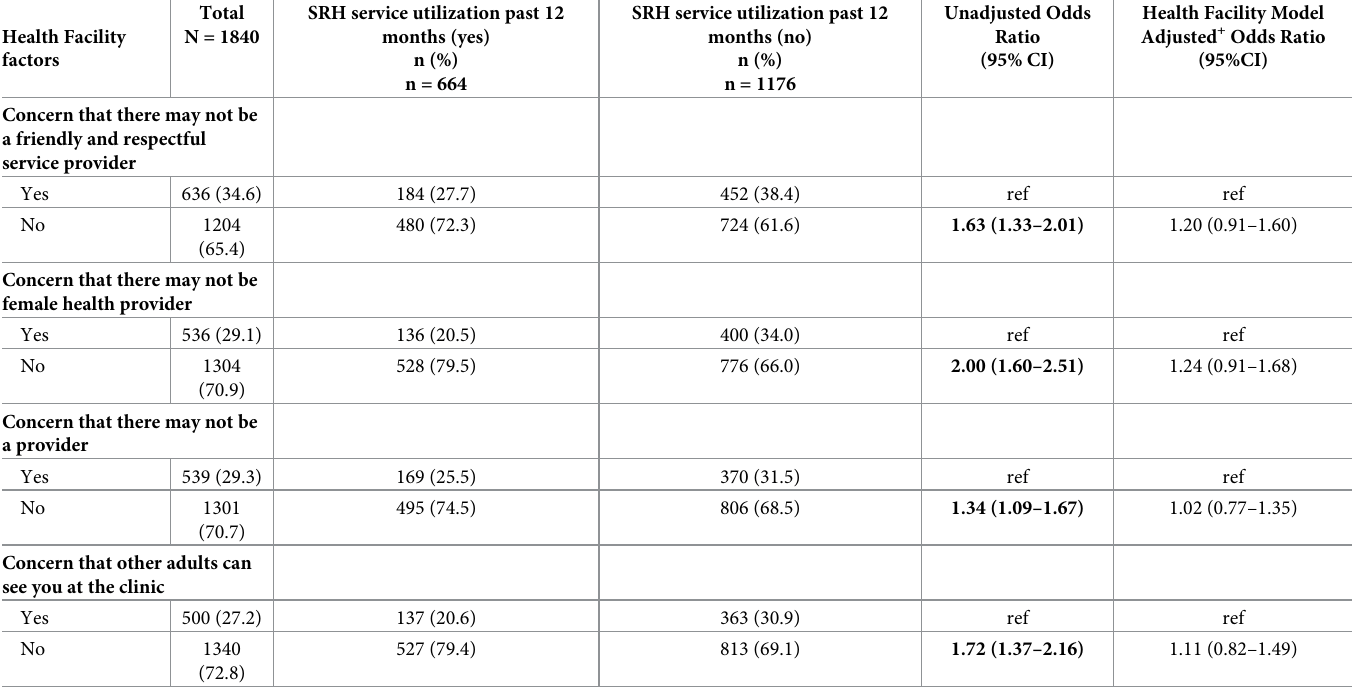
Table 3. Health facility level factors associated with SRH utilization among adolescents aged 15–19 in